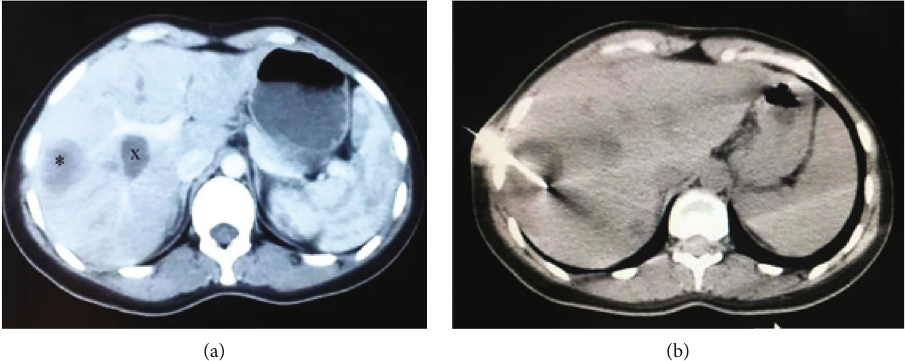
Figure 3: Postoperative abdominal CT scan showing (a) the remaining central hepatic cyst “ x ” and a remaining cavity “ ∗ ” ; (b) percutaneous management of the cyst and cavity under CT